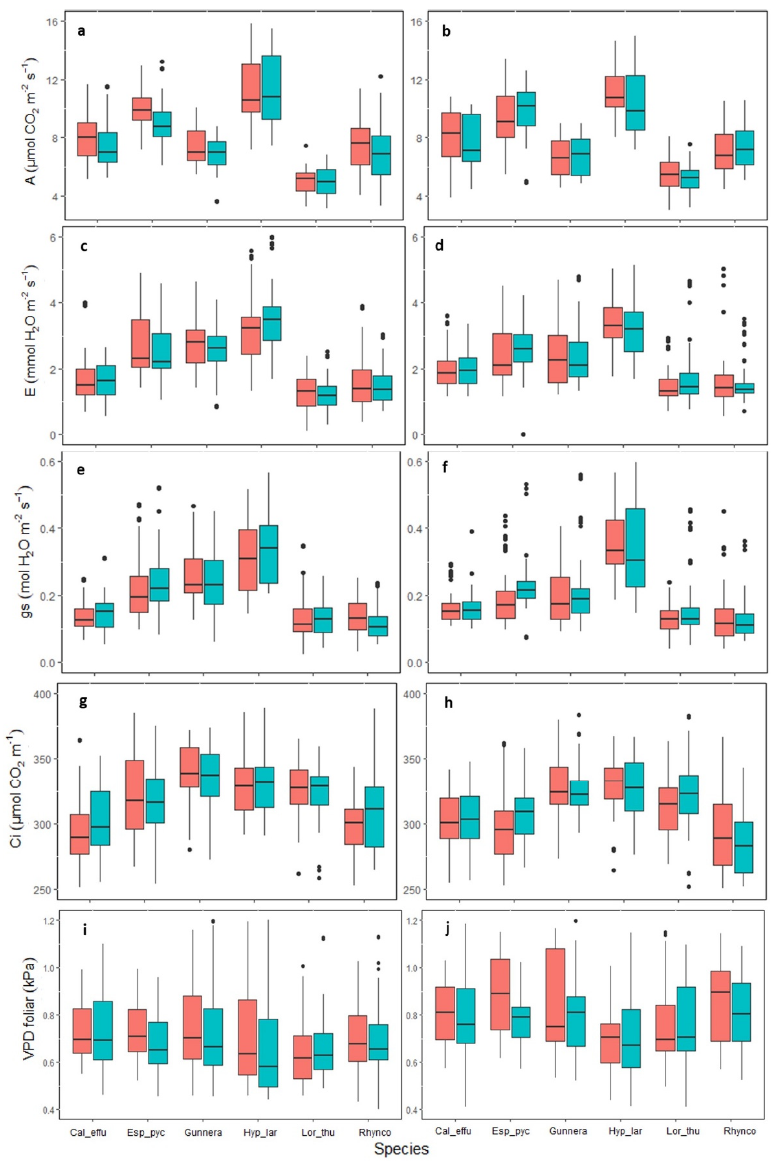
Figure 3. Gas exchange parameters in páramo plants in the conserved area (left) and intervened area (right), subjected to passive warming in the OTC treatment (red) and plots without passive warming in the control treatment (blue). Pooled data for all seasons, n = 75, p > 0.05. Cal_effu = Calamagrostis effusa , Esp_pyc = Espeletia pycnophylla , Gunnera = Gunnera magellanica , Hyp_lar = Hypericum laricifo- lium , Lor_thu = Loricaria thuyoides , Rhynco = Rhynchospora macrochaeta . Net photosynthesis ( a , b ), Transpiration ( c , d ), Stomatal conductance ( e , f ), Intercellular CO 2 concentration ( g , h ), and Leaf va- por pressure deficit ( i , j ). The black points are outliers.